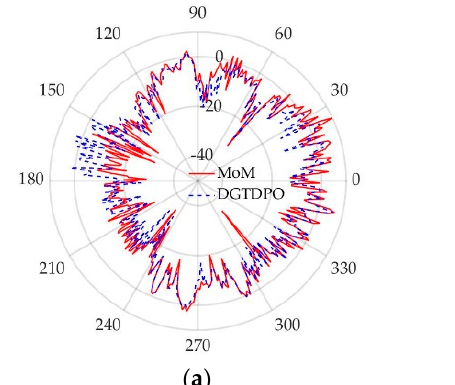
Figure 14. Transient scattered electric field of the multi-object-rough sea surface composite com- puted at theta = 0°, phi = 0°.